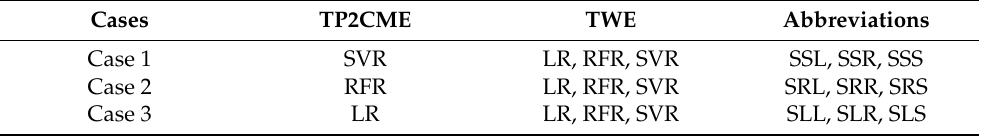
Table 5. Three experimental cases for determining the regression method to TP2CME and TWE. Cases